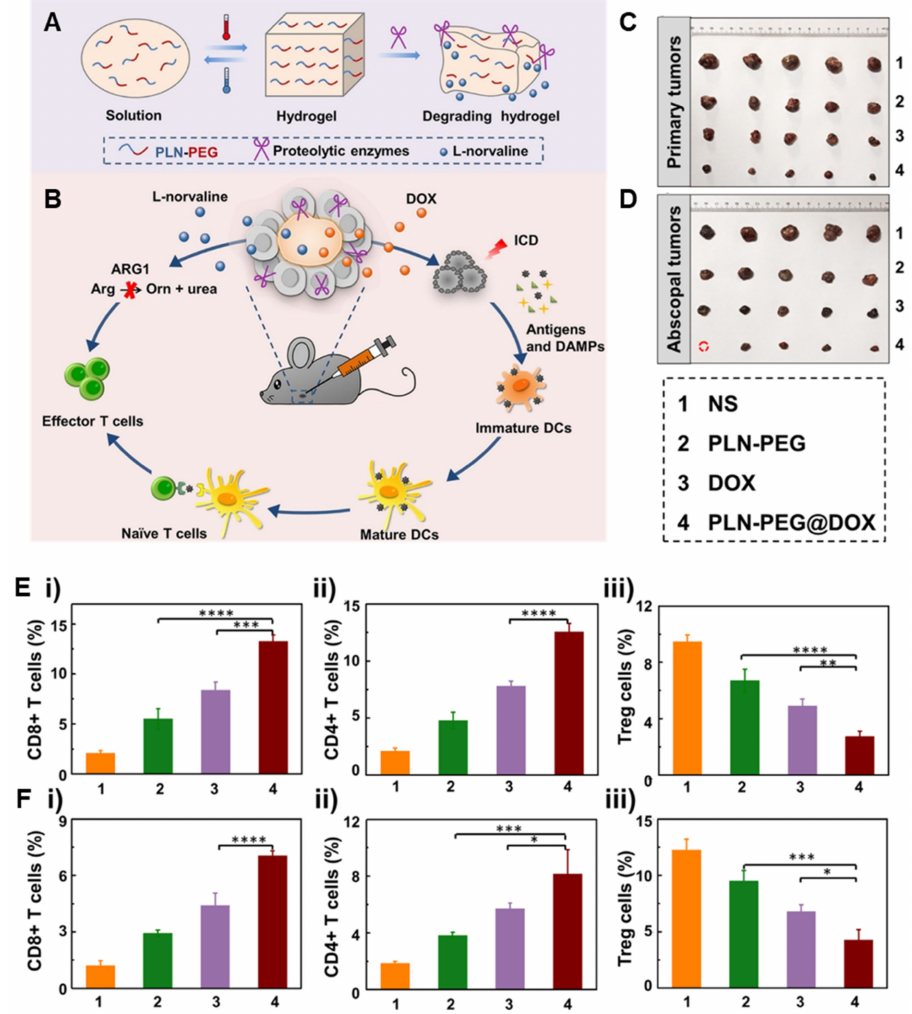
Figure 2. Injectable thermosensitive hydrogel with L-norvaline for combination chemoimmunother- apy. ( A ) Schematic illustration of thermosensitive hydrogel with L-norvaline. ( B ) Schematic illustra- tion of L-norvaline-based immunomodulation based on blocking the ARG1 pathway. Photographs of ( C ) primary and ( D ) secondary tumors after treatments. ( E ) Populations of ( i ) CD8 + , ( ii ) CD4 + , and ( iii ) regulatory T cells in primary tumors. ( F ) Populations of ( i ) CD8 + , ( ii ) CD4 + , and ( iii ) regulatory T cells in secondary tumors. * p < 0.05, ** p < 0.01, *** p < 0.001, **** p < 0.0001, one-way ANOVA for indicated comparison. Figures are reproduced from [46], with permission from